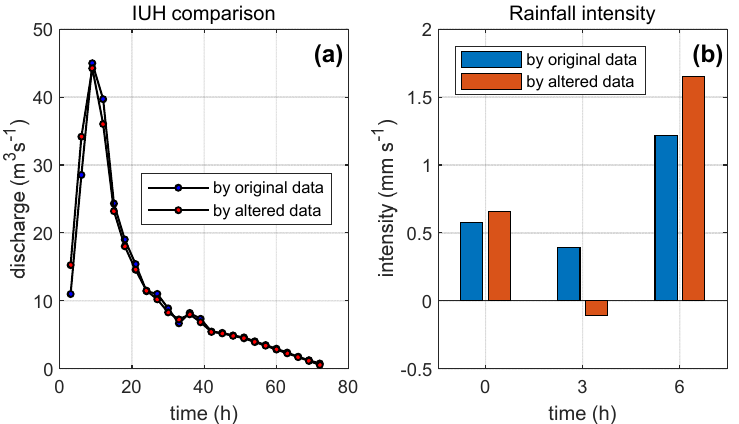
Figure 8. Comparison between IUHs and hyetographs for Storm No. 13 of Nenagh basin obtained by altering initial runoff value: ( a ) for initial runoff of 1.9 m 3 s − 1 (original), ( b ) for initial runoff of 3.0 m 3 s − 1 (altered).